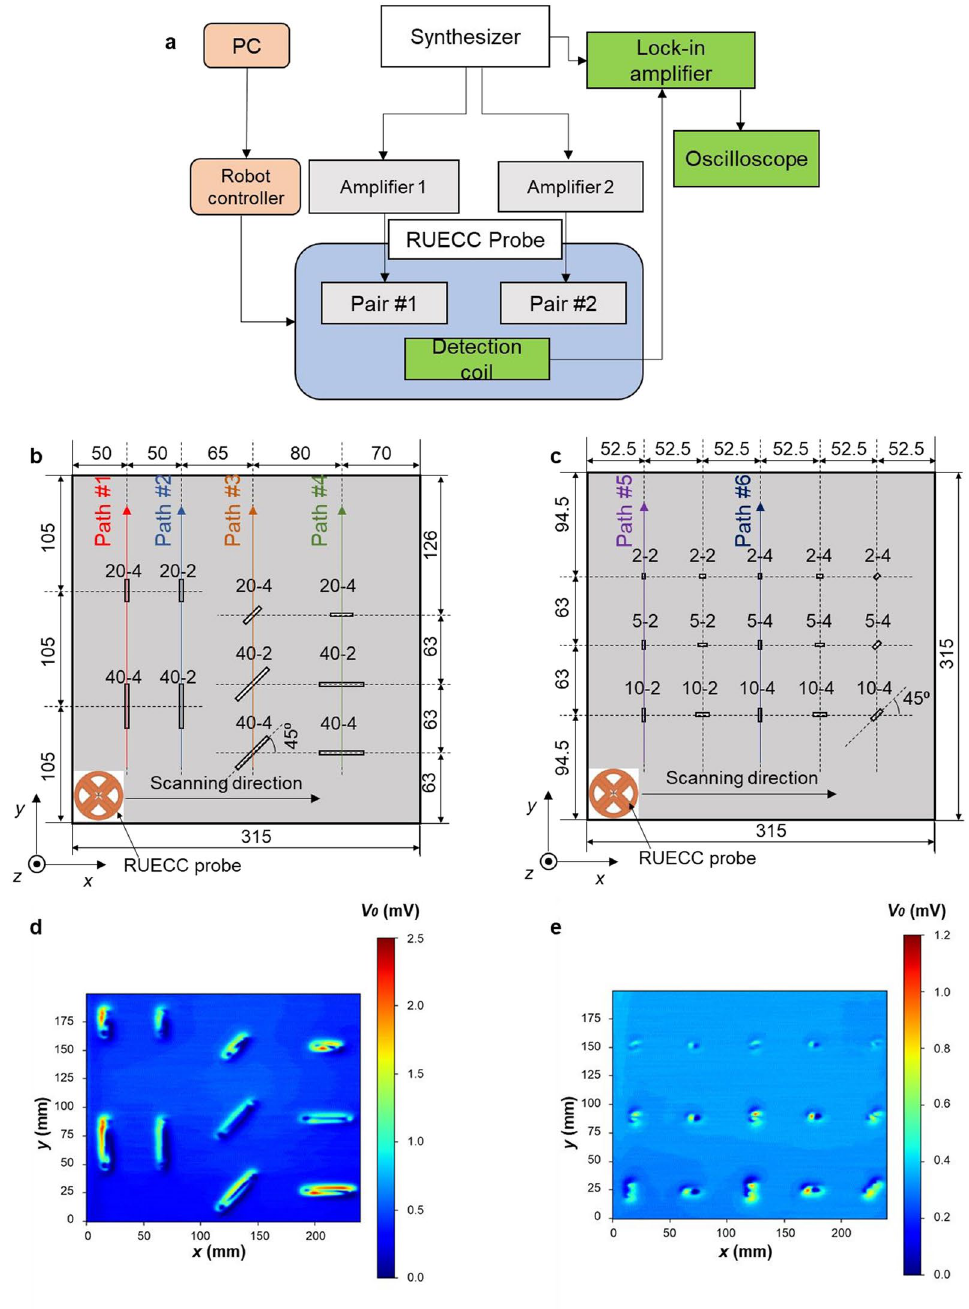
Figure 2. Experimental implementation with the RUECC probe. ( a ) Diagram of the experimental setup. ( b ) Experimental implementation on test piece 1. ( c ) Experimental implementation on test piece 2. ( d ) Experimental results of test piece 1. ( e ) Experimental results of test piece